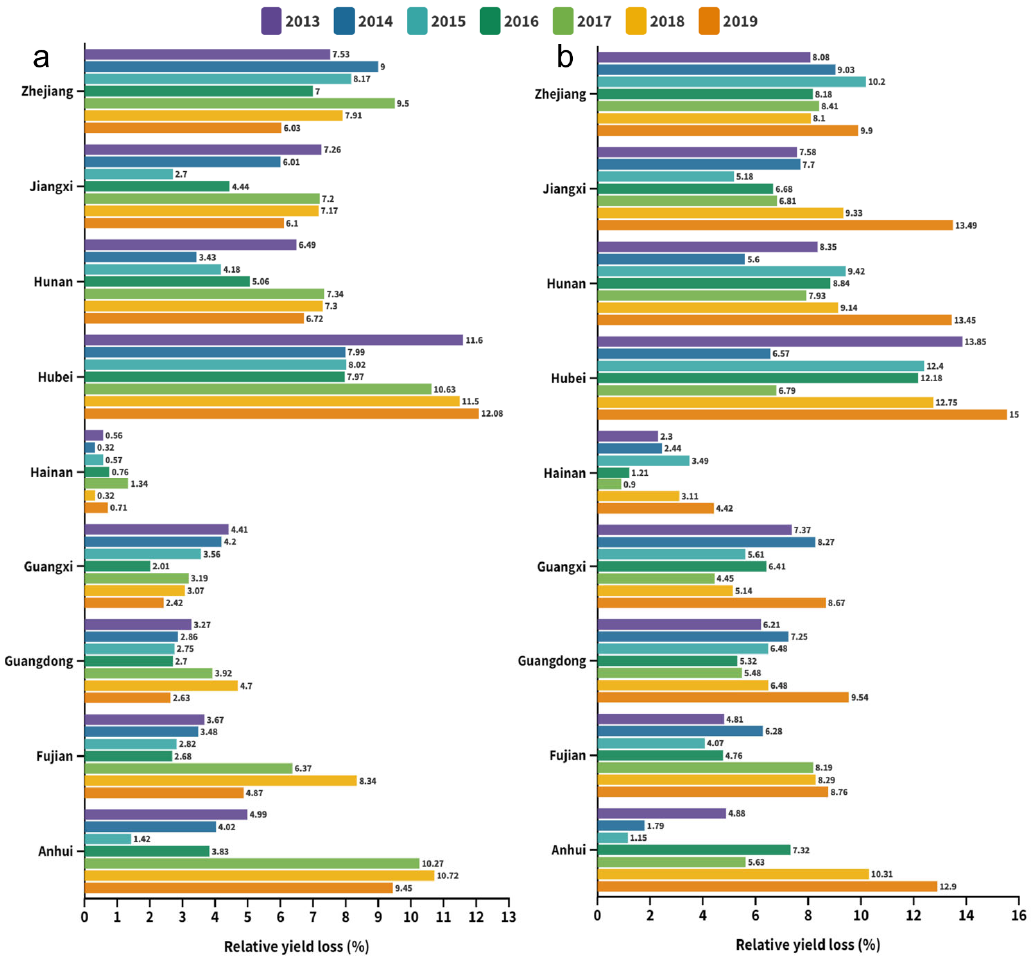
Figure 4. Regional statistics on the relative yield loss from 2013 to 2019. ( a ) Double ‐ early rice period and ( b ) double ‐ late rice period.